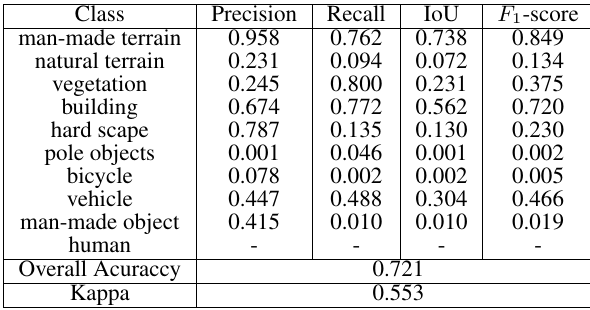
Table 3. Evaluation of the feature-based method against the Testset 2 for all points in that